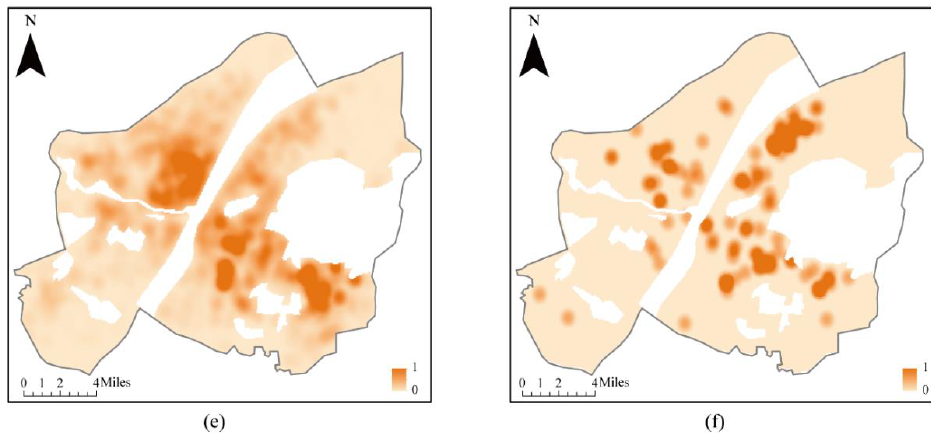
Figure 5. Kernel density distribution diagram of various fire risk factors: ( a ) flammable and explosive; ( b ) vulnerable population; ( c ) crowded population; ( d ) key protection; ( e ) general fire; ( f ) emergency risk aversion.